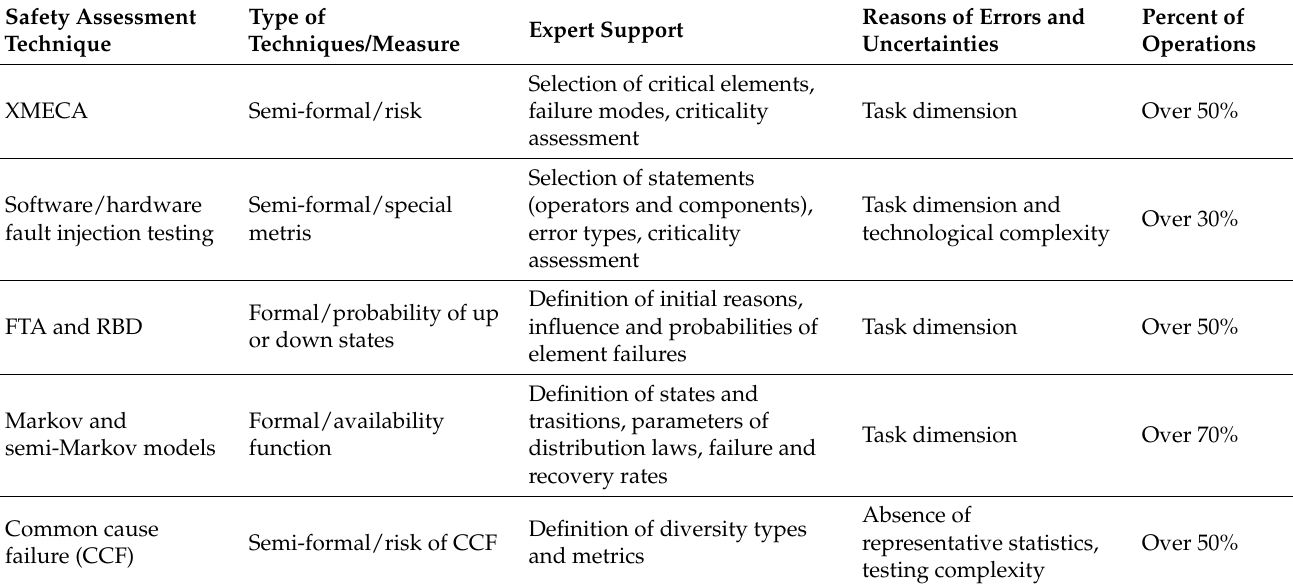
Table 1. Analysis of expert impact on application of safety assessment